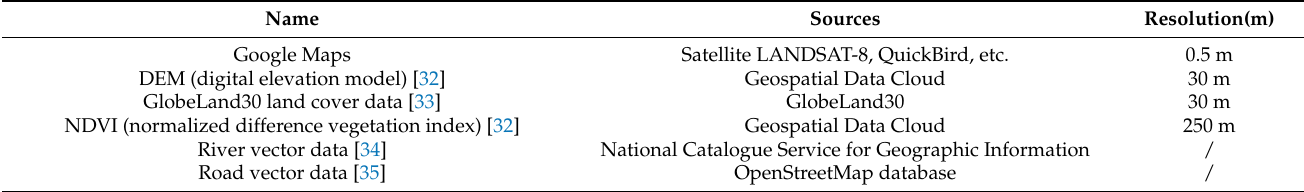
Table 2. Environmental data sets used in the analyses, and their sources and resolution. Resources can be downloaded from the website in the citation following the data